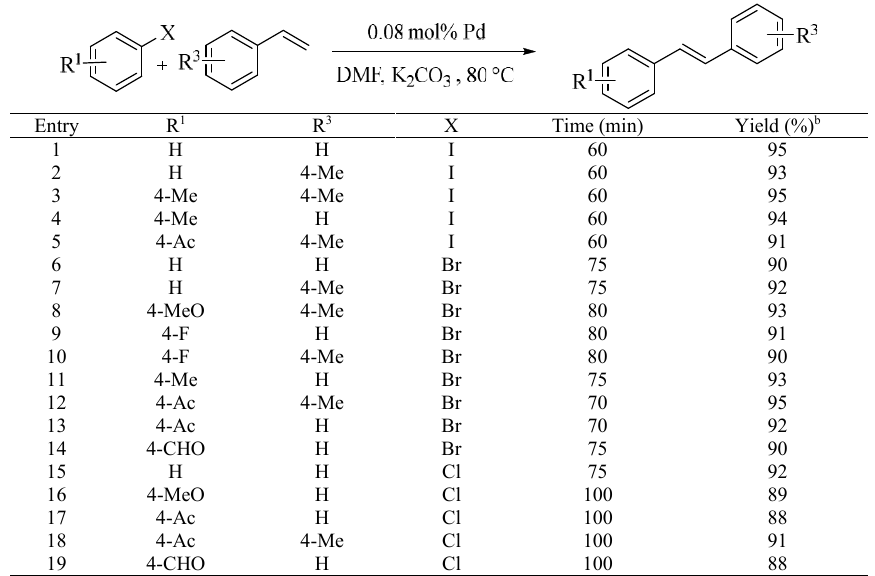
Table 4. Heck reaction of aryl halides with styrenes catalyzed by MNP/HPG-CA/Pd a